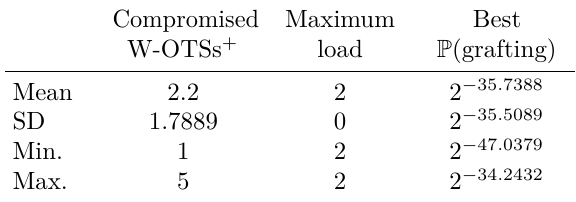
Table 15: Analysis of the universal forgery in N = 5 fault attacks against SPHINCS + - shake-256s-robust at layer l ∗ =